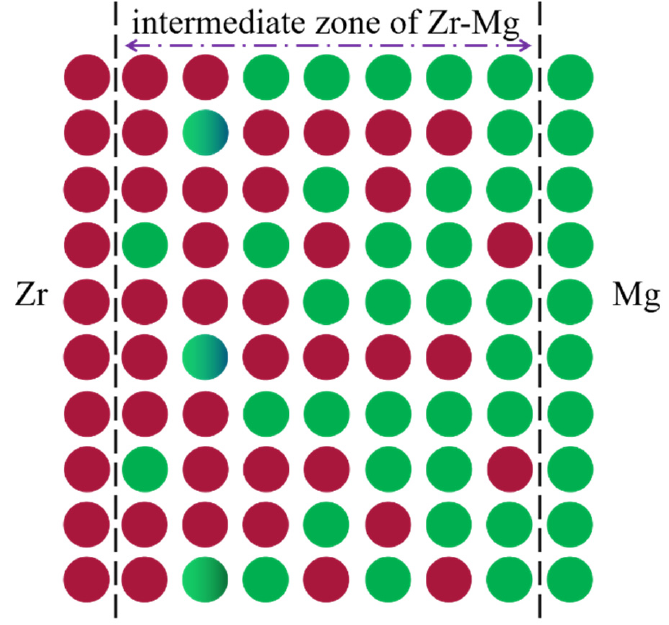
Figure 5. Schematic diagram of the formation of the Zr–Mg transitional layer on the surface of Zr particles during the solidification process.